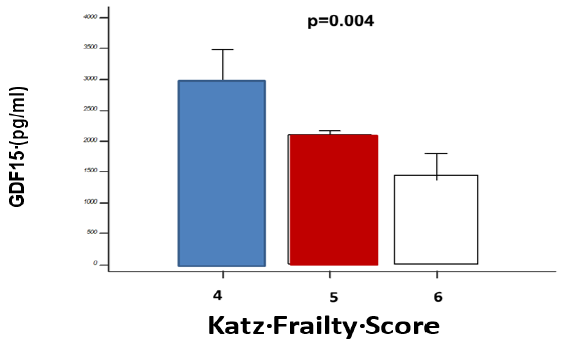
Figure 2. Relationship of GDF15 levels with the Katz frailty score. Analysis of variance shows significant differences in circulating GDF15 levels (pg/mL) as a function of the Katz frailty score (4 to 6), with higher values in patients with a lower Katz score (higher frailty).